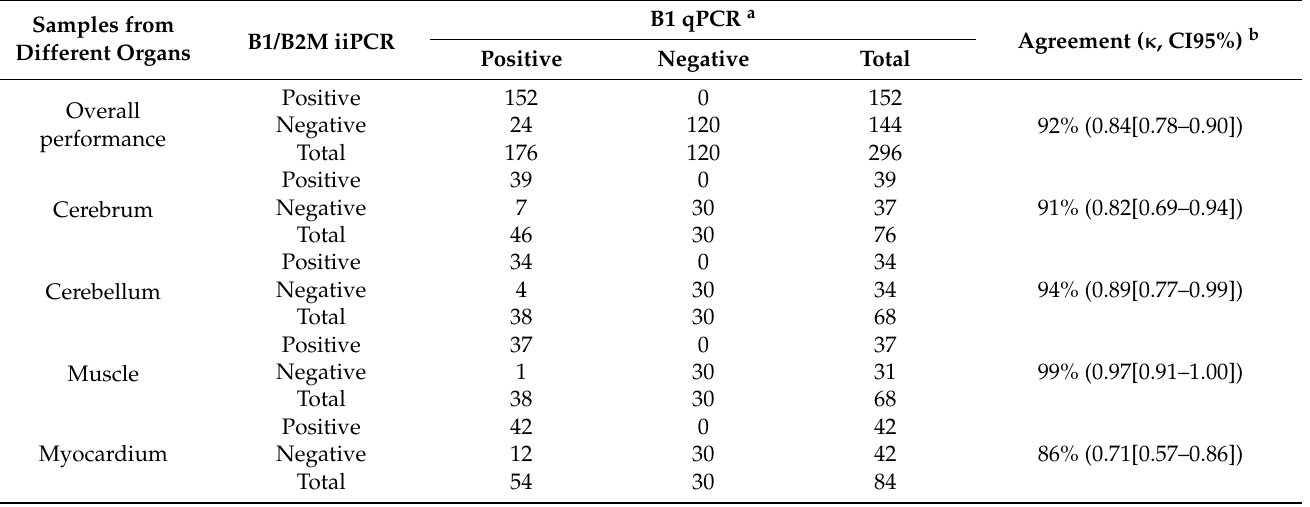
Table 6. Performance evaluation of the B1/B2M iiPCR using T. gondii -spiked cetacean